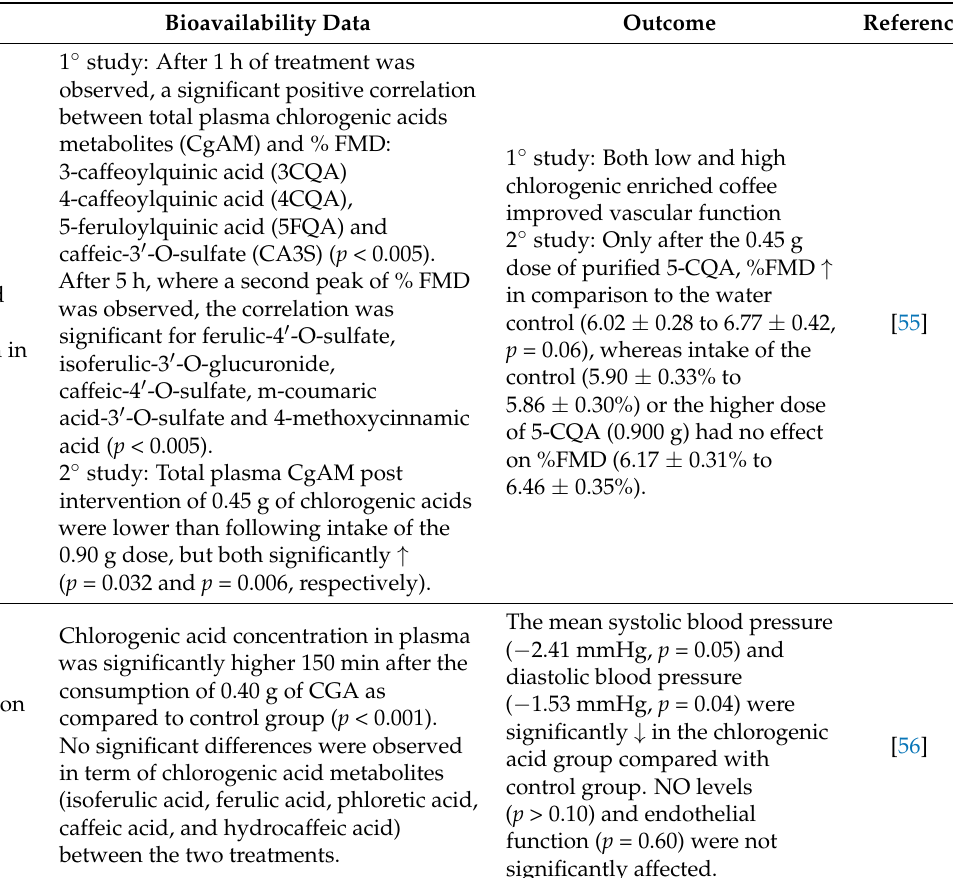
Table 4. Phenolic acids’ beneficial effects and bioavailability in human